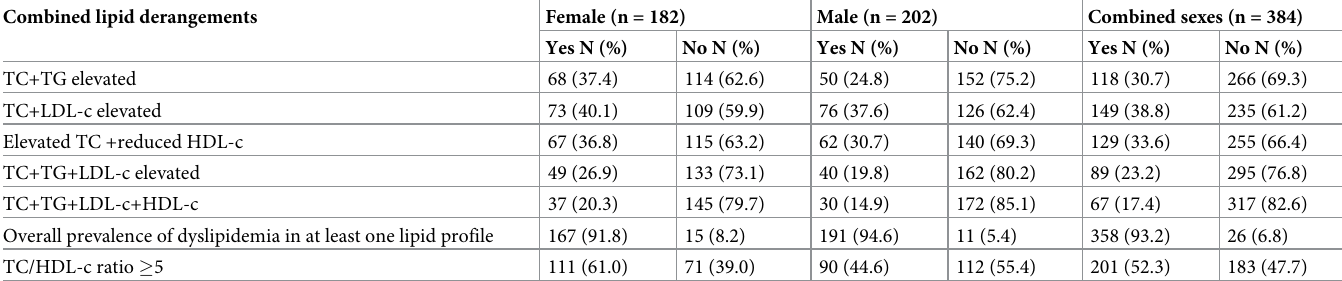
Table 4. Co-occurrence of the four lipid derangements among hypertensive patients stratified by gender in Northeast Ethiopia, 2021. Combined lipid derangements